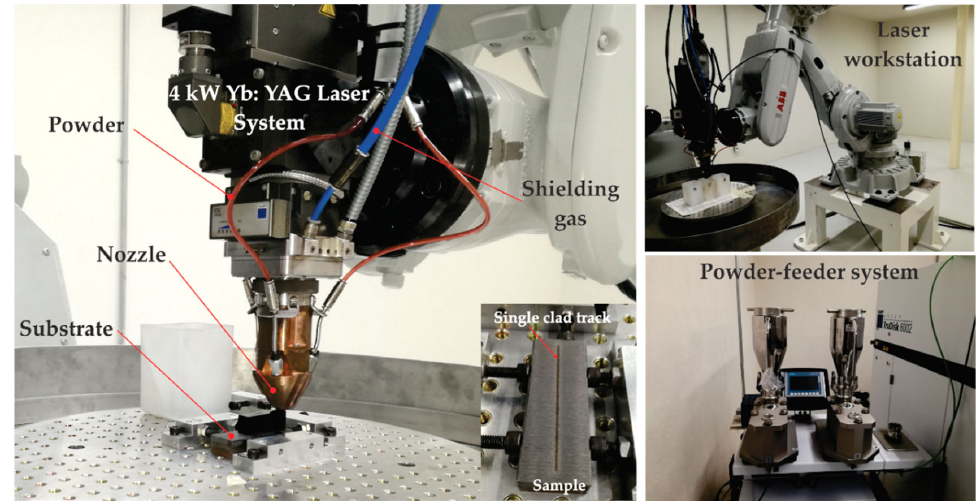
Figure 1. Experimental setup for the laser cladding process. Table 1. Yb: YAG Laser operational parameters and calculated average energy per unit area.